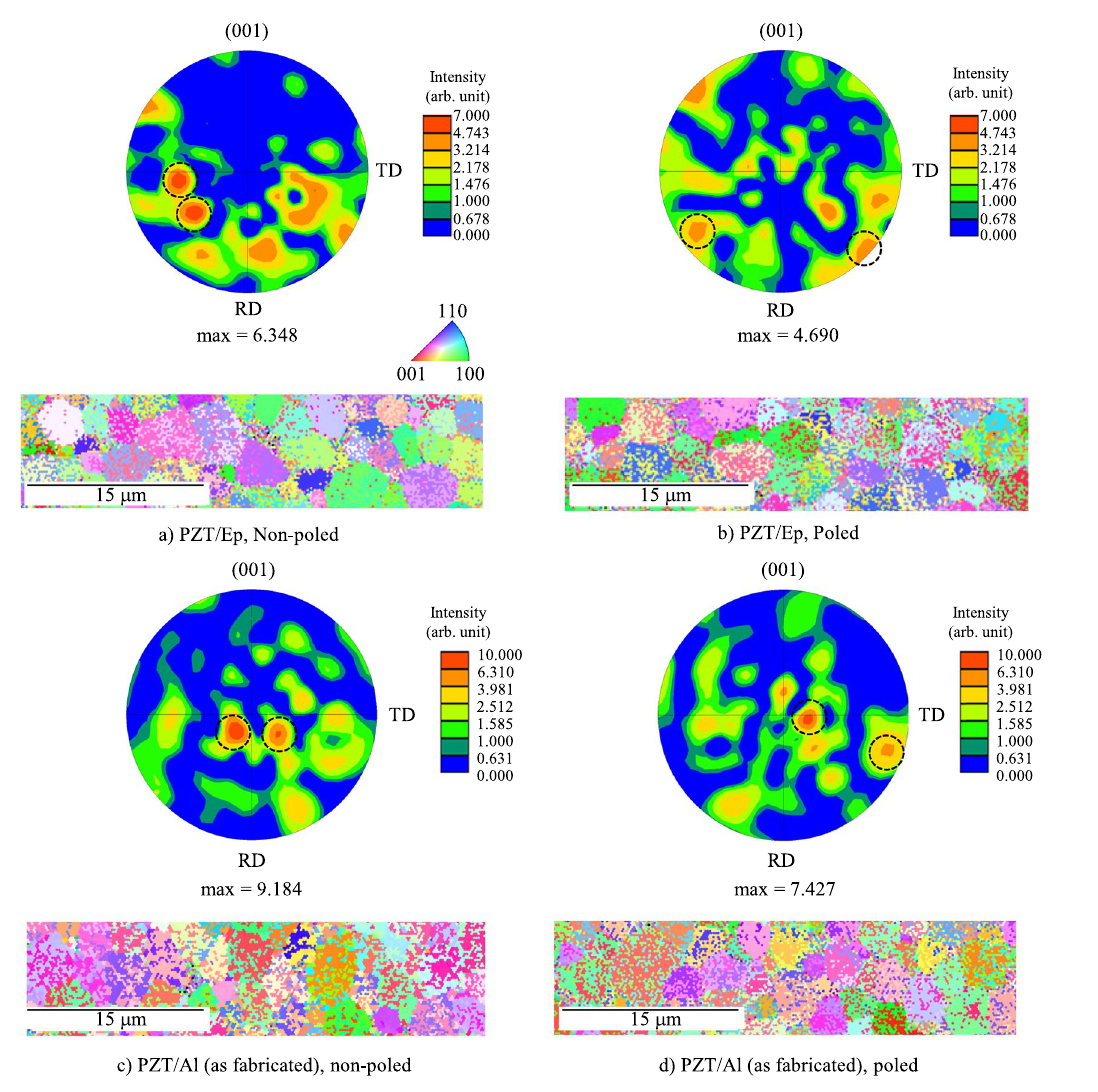
extremely strong orientation is observed because of the residual compressive stress along the ND. After polarization, the crystal ori- entation transitions to TD in both the